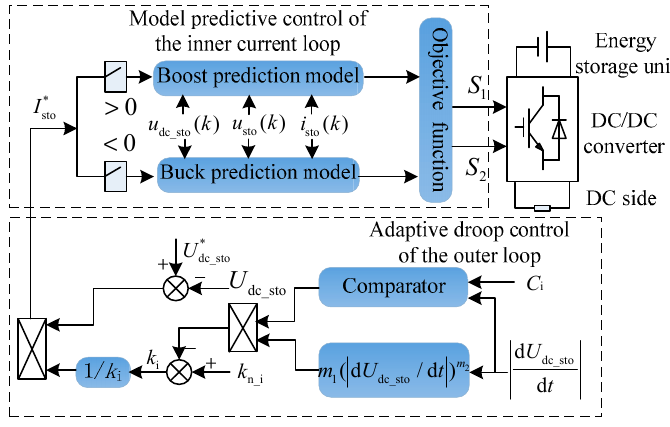
Figure 6. Predictive control model of an energy storage system adopting adaptive droop control in the outer loop.